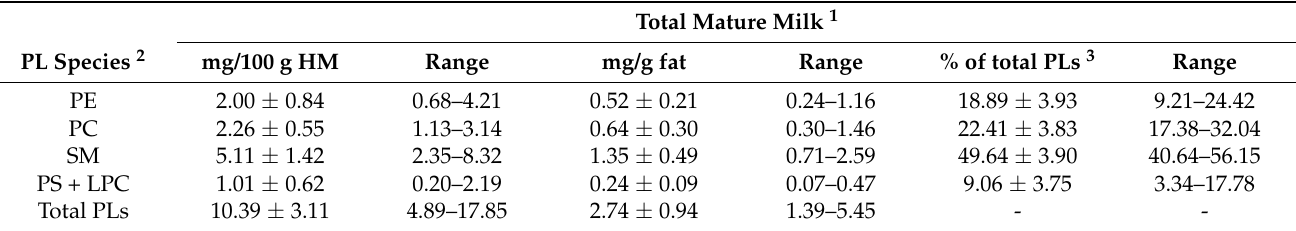
Table 1. Phospholipid (PL) concentrations in human milk (HM) from the lactating mothers in Korea.